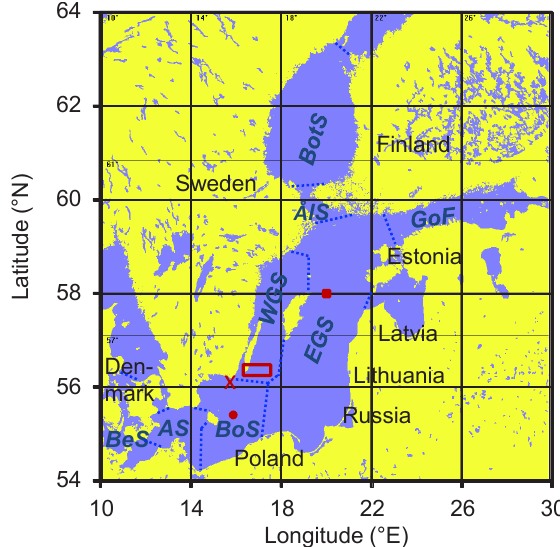
Figure 1. Map of the Baltic Sea showing the Belt Sea (BeS), Arkona Sea (AS), Bornholm Sea (BoS), eastern Gotland Sea (EGS), west- ern Gotland Sea (WGS), Åland Sea (ÅlS), Bothnian Sea (BotS), and Gulf of Finland (GoF). The borders are sketched as blue dashed lines; the upwelling study site is framed in red, the SMHI’s meteo- rological station Utklippan A is shown as a red cross, the Bornholm Deep station as a red solid circle, and the Fårö Deep station as a solid red